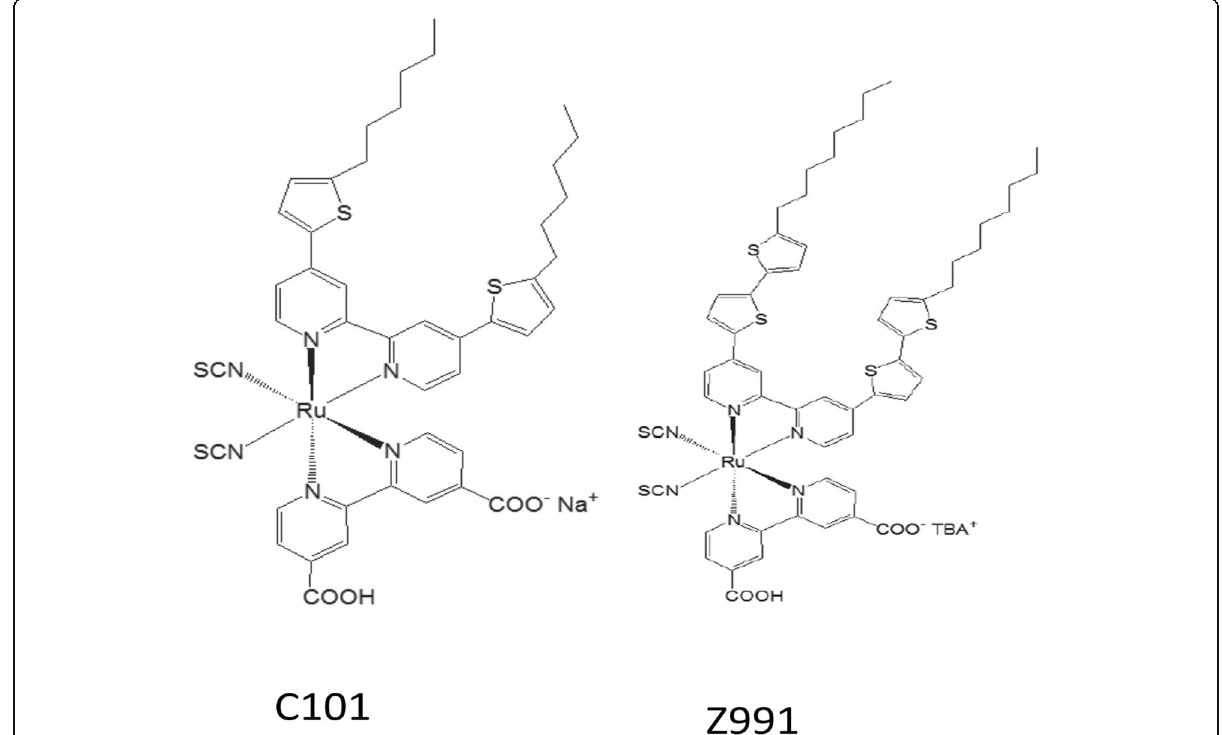
Fig. 13 Molecular structure of C101 and Z991 sensitizers